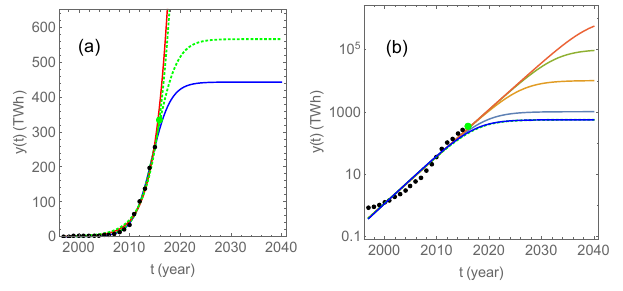
Figure 3. The black bullets represent global solar power consump- tion data for the period 1997–2015, and the green bullet for 2016; all according to BP Statistical Review of World Energy (2017). In panel (a) , the red and blue curves are exponential and logistic model fits to the 1997–2015 data, respectively. The green, dashed curves are fits to the 1997–2016 data. In the logarithmic plot in panel (b) , the blue curve, and the green, dashed curve on top of it (almost in- visible) is a fit of the logarithm of the logistic model to the logarithm of the data with the parameter P max fixed to 550TWh. For the green curve, the green point is included, for the blue curve, it is not. The other curves are similar fits with P max fixed to 10 3 , 10 4 , 10 5 , and 10 6 TWh, respectively. The residual Q 2 decreases monotonically to the value corresponding to an exponential fit as P max → ∞ .